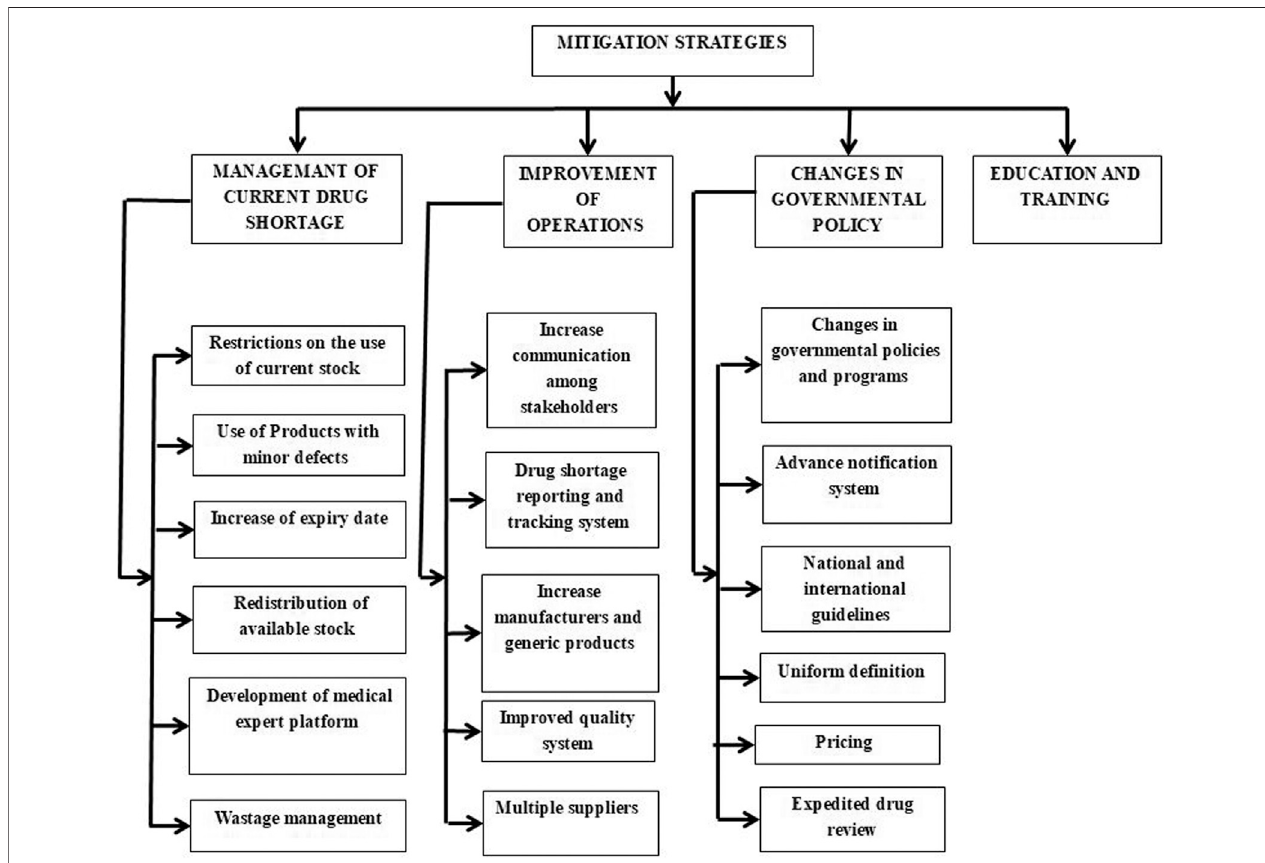
FIGURE 5 | Mitigation